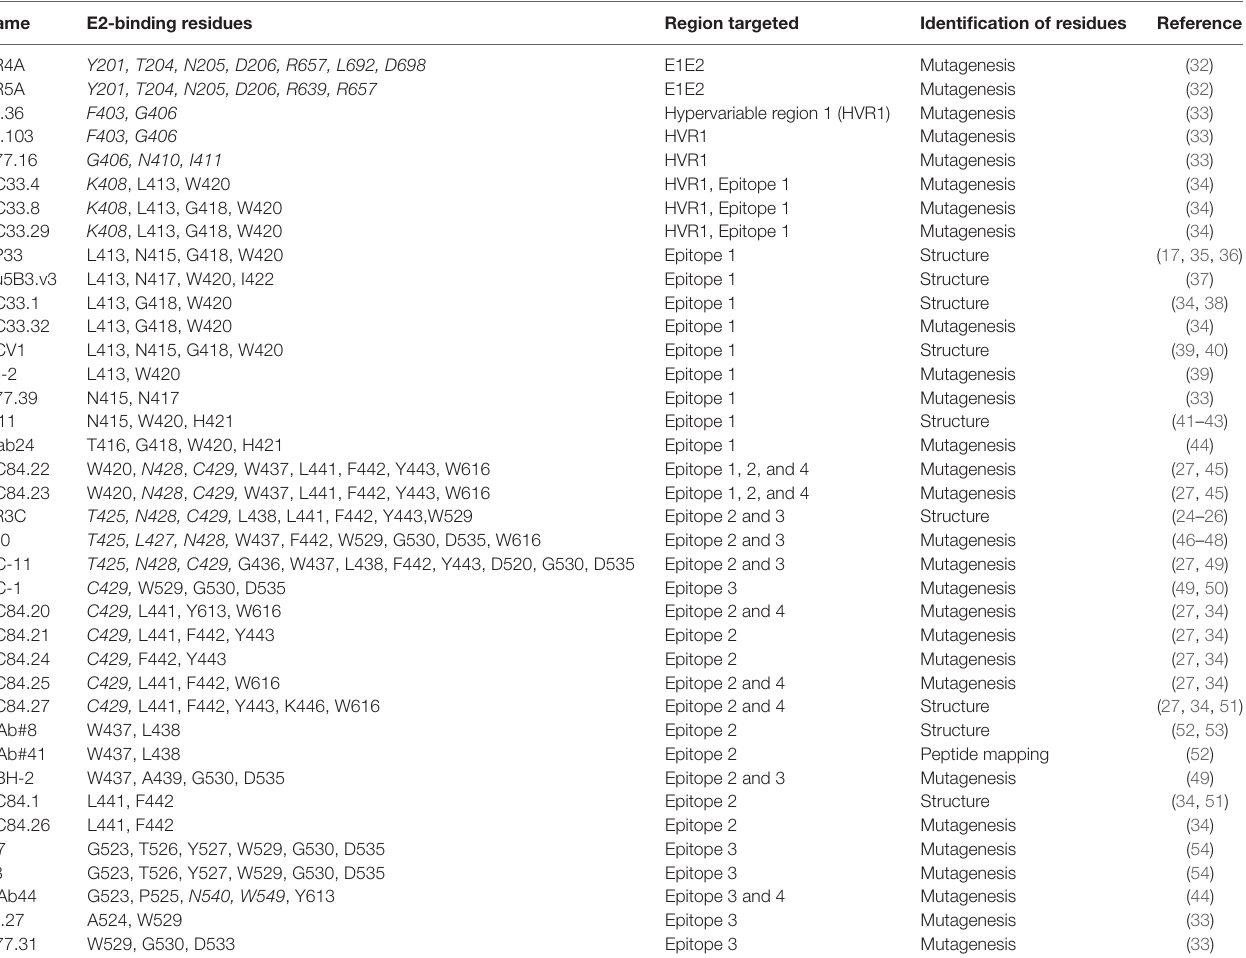
TaBle 1 | Broadly neutralizing antibodies and their epitopes analyzed in the